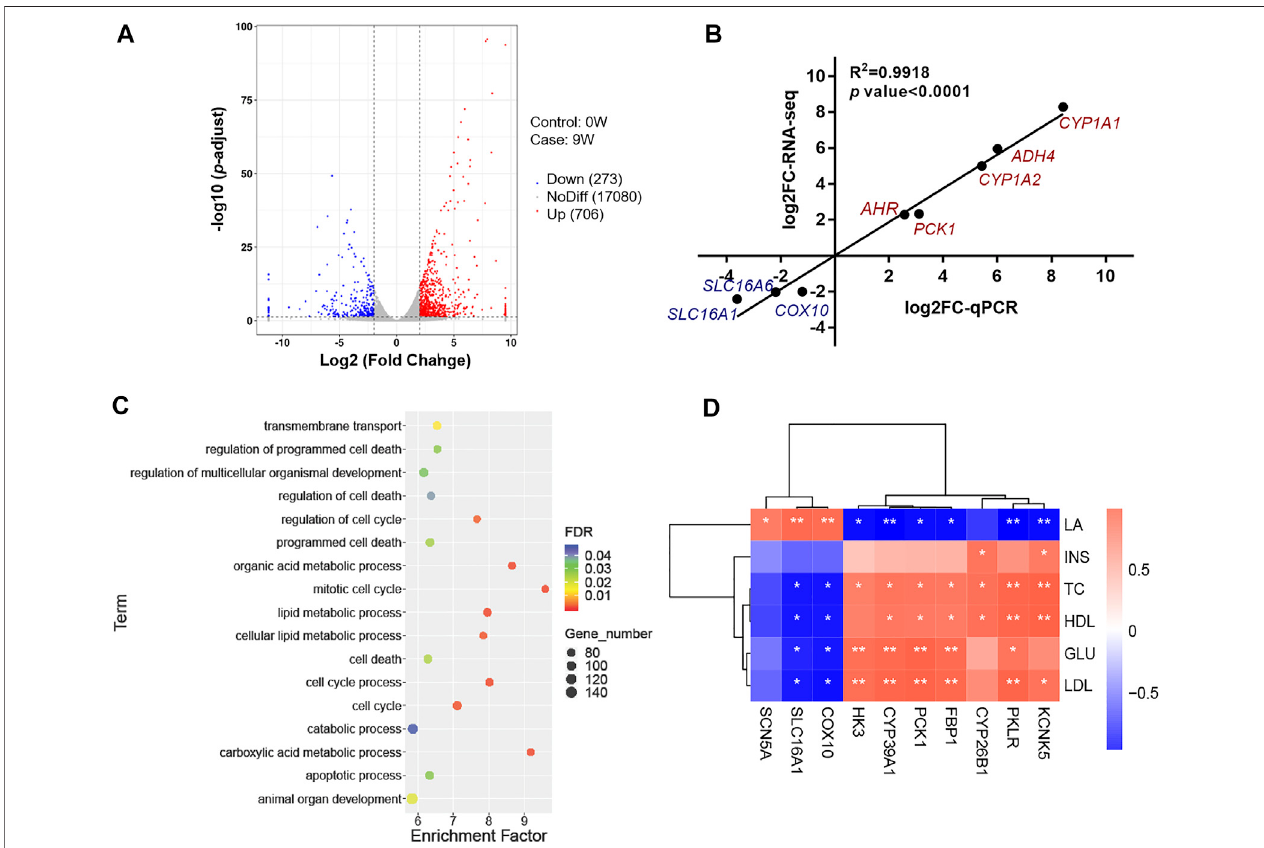
FIGURE 2 | Analysis and veri fi cation of RNA sequencing data. (A) Volcano plot showing expressed genes and criteria for DEG classi fi cation; (B) Analysis of the correlationbetweenRNA-seqandqPCR; (C) FunctionalenrichmentanalysesofDEGs; (D)